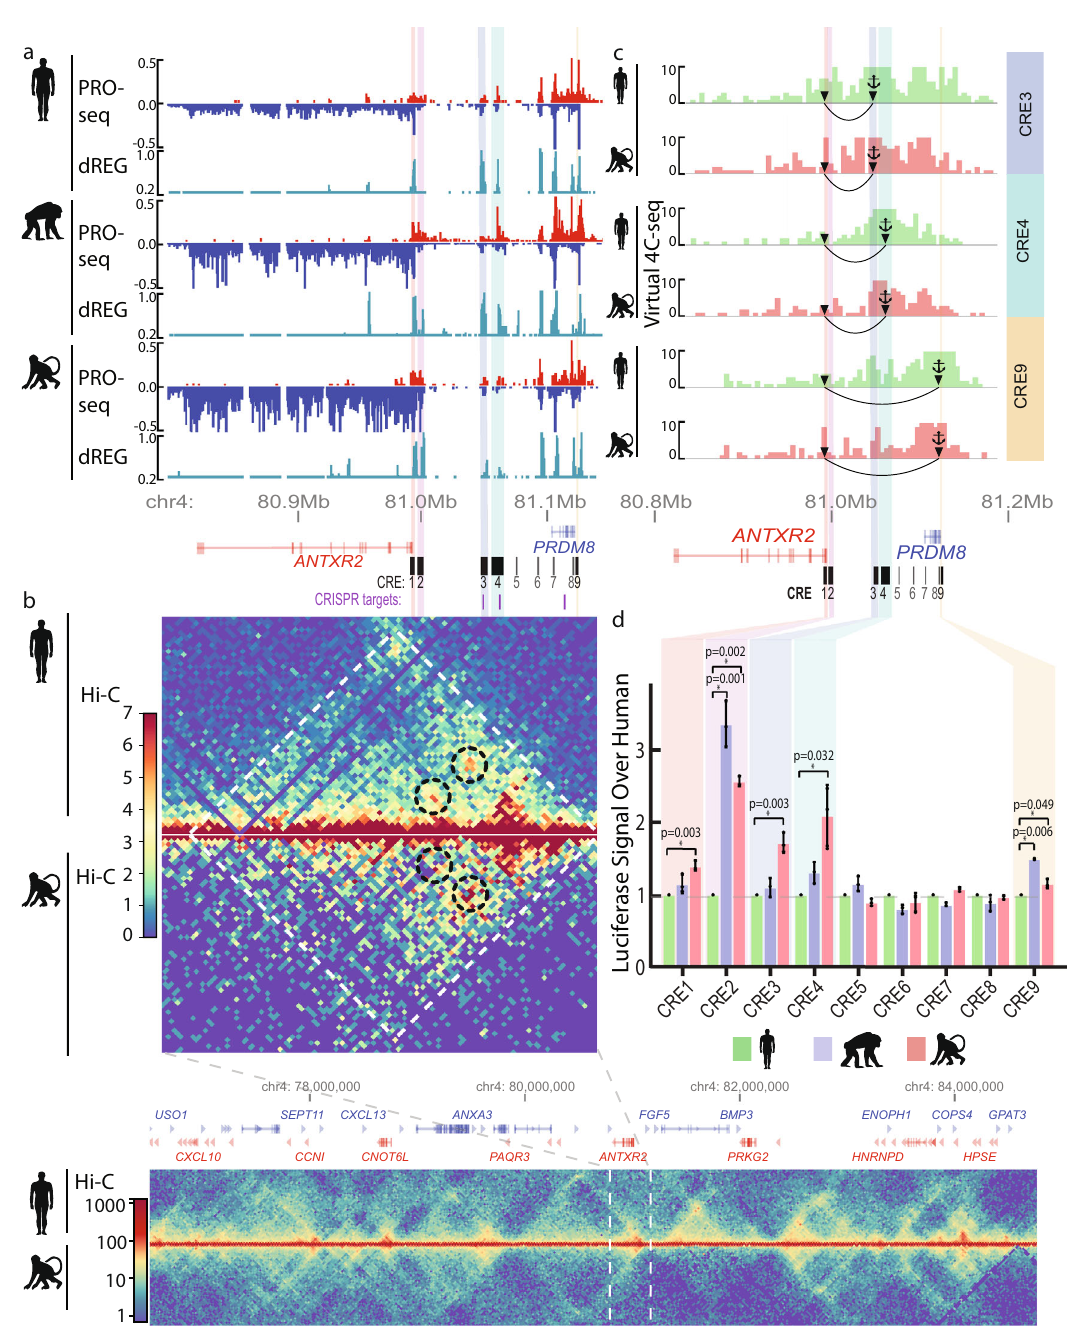
Fig. 2 Changes in ANTXR2 cis -regulatory element activity and chromatin structure. a Genome browser shot of CD4 + T-cell PRO-seq (normalized by reads per million, plus strand in red, minus strand in blue) in human, chimpanzee, and rhesus macaque. Regulatory elements predicted by dREG are shown in teal. Cis -regulatory elements (CREs) tested in this study (CRE1-9) are shown below the data tracks. CREs having decreased activity in human (as determined by luciferase in ( d )) are shaded. Overlap with validated CRISPR targets 46 that result in reduced ANTXR2 expression are shown below the CREs in purple. b Hi-C/Micro-C in CD4 + T cells from human and rhesus macaque. Normalized contacts are shown in the heatmap scale to the left. ANTXR2 is located in the same topological domain (TAD) as the upstream gene PRDM8 in both species. TADs are marked with white dotted lines. Focal contacts with the ANTXR2 promoter are circled with black dotted lines. Zoomed-out gene-level Hi-C contacts are pictured below, with the region shown in the top panel outlined in white. c Virtual 4C-seq signal calculated based on the number of Hi-C contacts for CREs tested in the luciferase assay. CREs with decreased activity in human are colored. The anchor symbol at each CRE represents the bait region that all contacts are derived from. The arrow at the end of the arc denotes the ANTXR2 promoter. d Luciferase assay performed in Jurkat cells to test the activity of regulatory elements in human, chimpanzee, and rhesus macaque shows lower activity in human compared with either chimpanzee or rhesus macaque for CRE1, CRE2, CRE3, CRE4, and CRE9. Data are presented as mean values + / − SEM. One-sided t tested used and signi fi cant P values are shown in the fi gure. n = 3 independent transfections in each species. Source data are provided as a Source Data fi